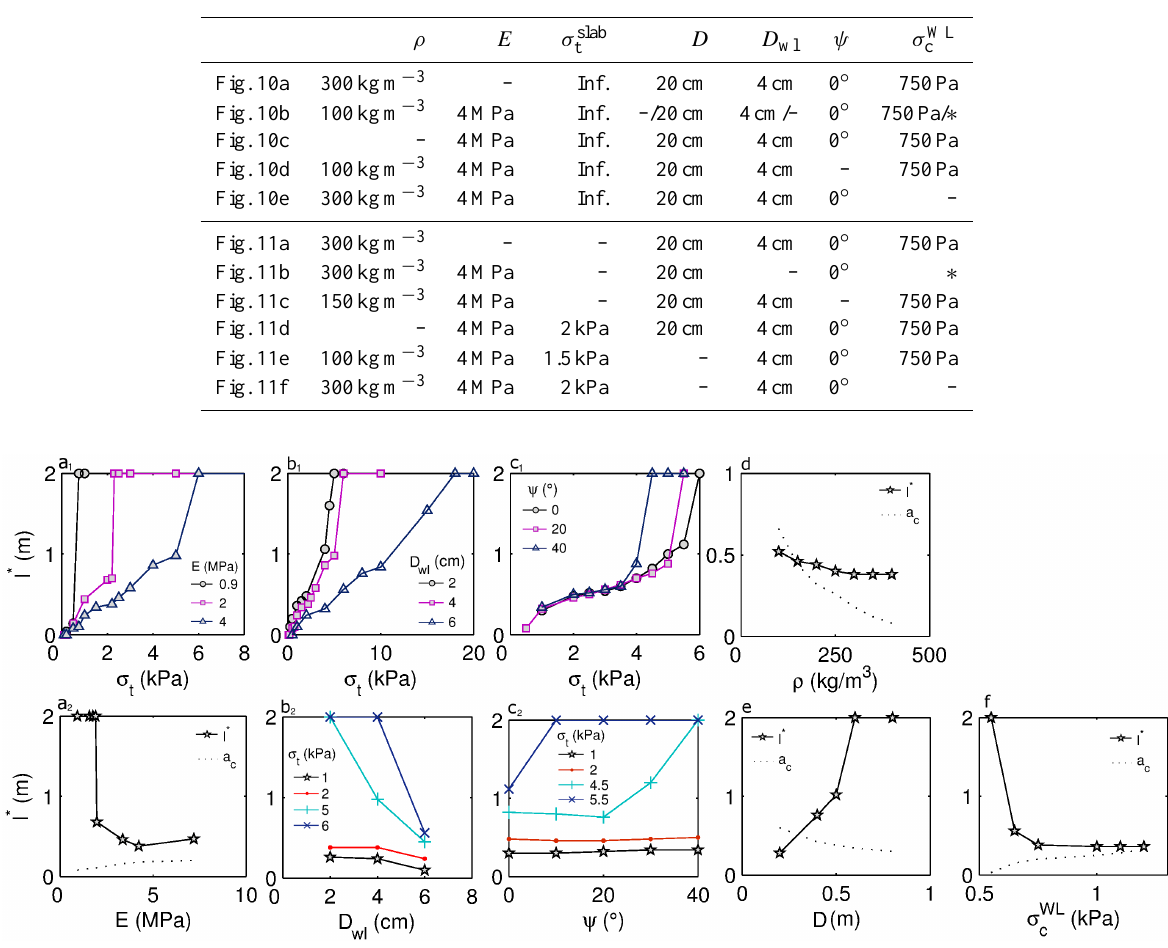
Figure 11. Crack propagation distance l ∗ as a function of the tensile strength σ t and the Young’s modulus E of the slab (a 1 – a 2 ) , the tensile strength σ t and the WL thickness D wl (b 1 – b 2 ) , the tensile strength σ t and the slope angle ψ (c 1 – c 2 ) , slab density ρ (d) , slab thickness D (e) and WL compressive strength σ WL c (f) . a c denotes the critical cut length for crack propagation. The parameters used for these plots are given in Table